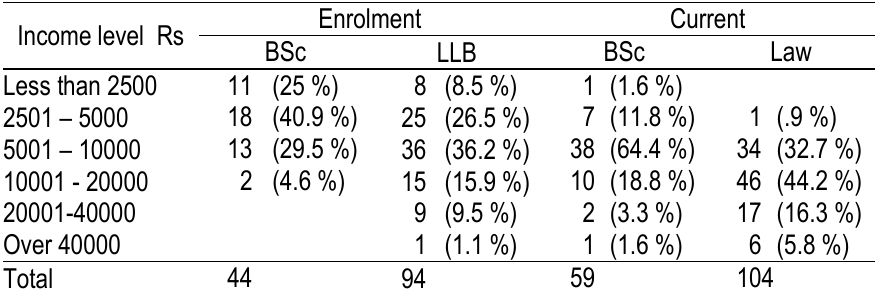
Table 4. Income Levels of Respondents - At Enrolment and